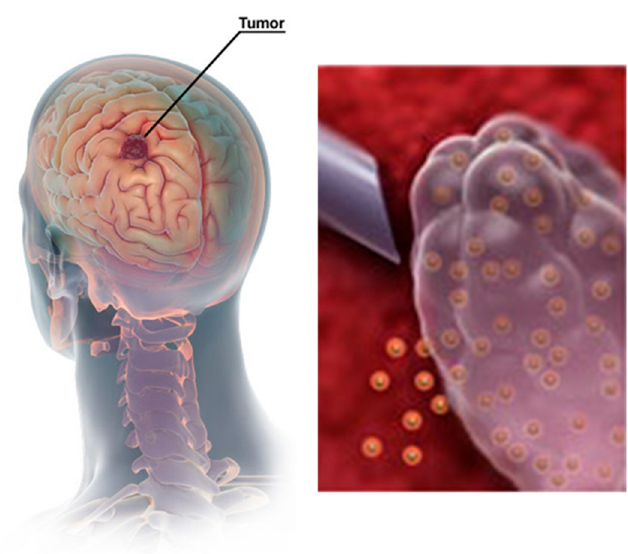
Figure 8. Schematic representation of stimuli-responsive drug nanocarriers locally released from a gel depot. In situ-forming gels may be injected in the tumor environment in order to facilitate a sustained release of the nanoparticles upon degradation.